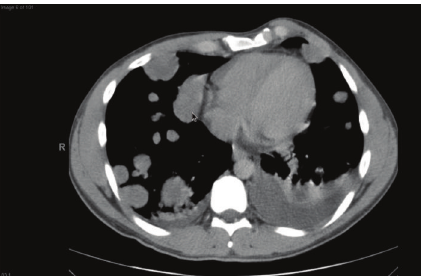
Figure 2: CT of the chest, revealing extensive metastatic disease with numerous pulmonary nodular masses and bilateral pleural effusions.